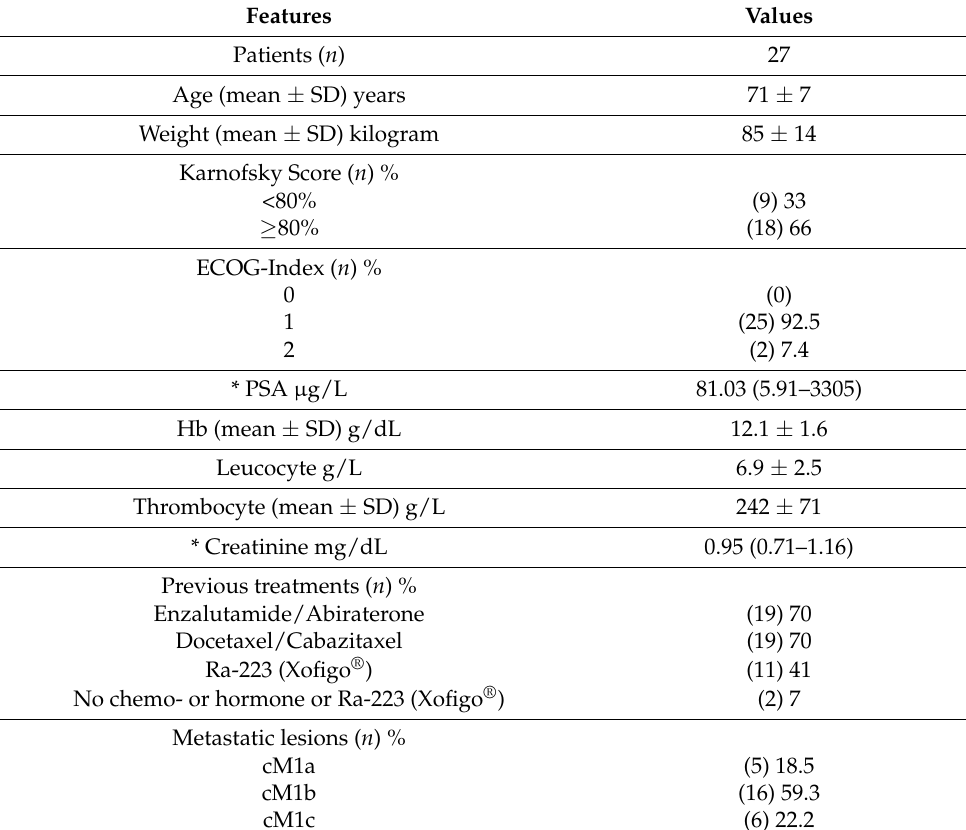
Table 1. Clinical characteristics of the entire studied mCRPC patients prior to receiving any PSMA-RLT.